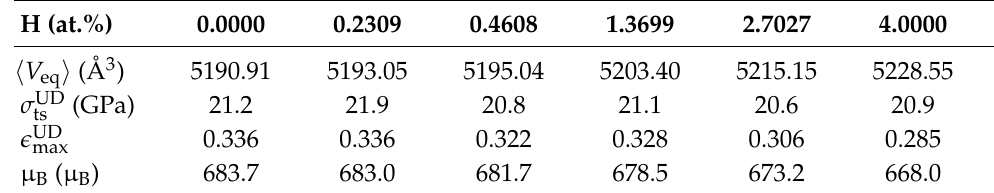
Table 1. The computed characteristics of Fe 3 Al with and without hydrogen atoms (with different hy- drogen concentrations): An averaged supercell volume (cid:104) V eq (cid:105) for a minimum-energy stress-free state (432 Fe and Al atoms plus 0–18 H atoms), the theoretical tensile strength σ UD ts (GPa), the corresponding maximum strain (cid:101) max , and the total magnetic moment per the supercell (in µ B ). H (at.%) 0.0000